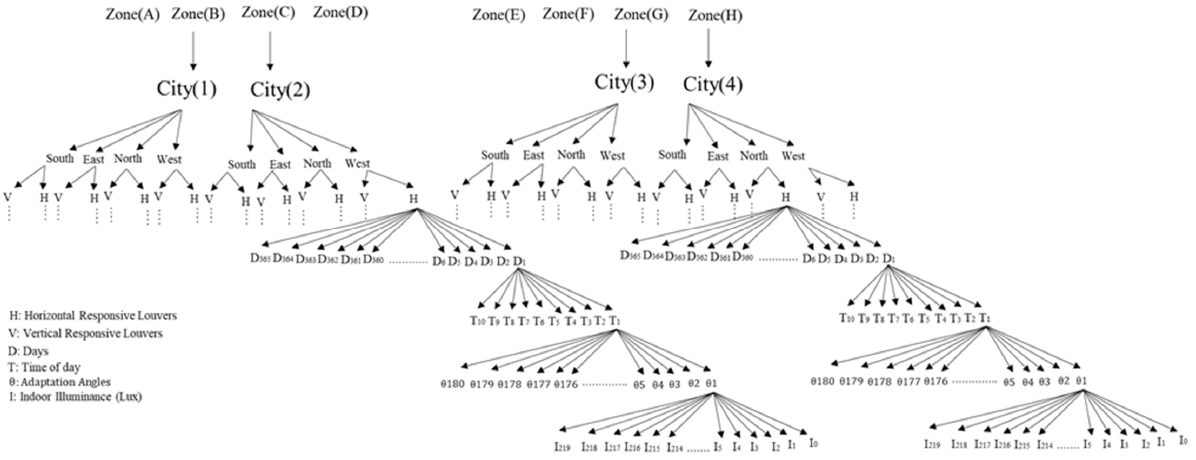
Figure 3. Structure of the simulation